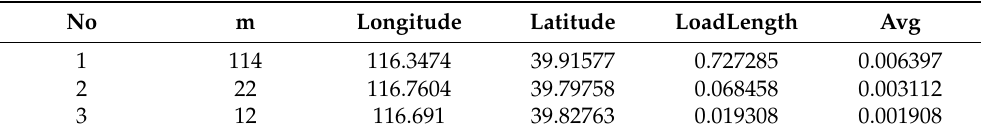
Table 8. The clustering results of the algorithm in this paper for the DS1 dataset.